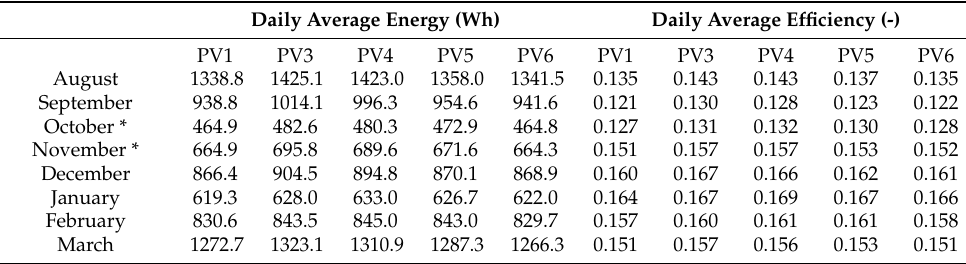
Table 5. Daily average electric energy, monthly electric energy, and daily average efficiencies of the six modules equipped with cooling